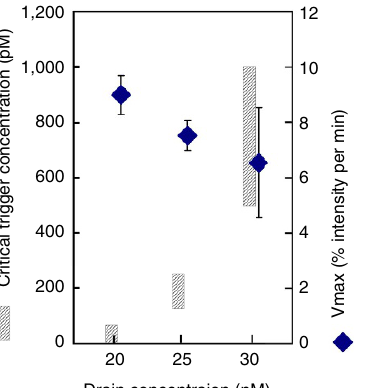
Figure 4 | Tunable threshold can be implemented with drain templates at the cost of amplification rate: 50nM of autocatalytic template b to b was incubated with 20, 25 or 30nM of drain template drain b and various concentrations of trigger b ; the hashed bars indicate the range, within which the threshold trigger concentration required to switch the system to the high state can be found; the blue dots and error bars, respectively, indicate the mean and s.d. of the maximum amplification rate Vmax measured in the presence of 1, 3 and 9nM of trigger b .